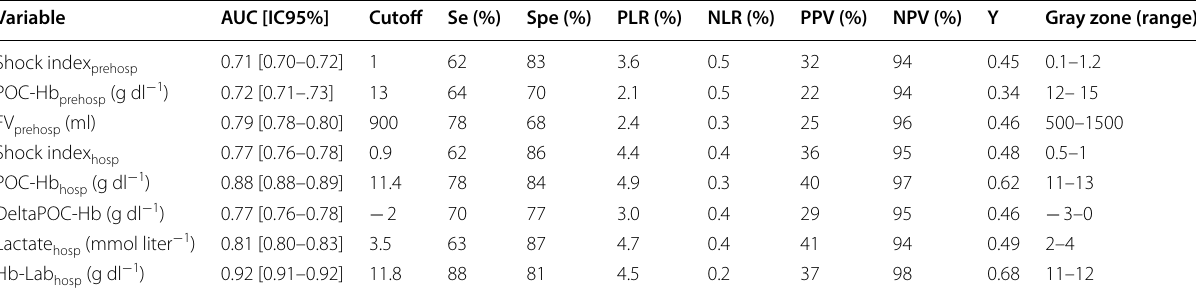
Table 3 Predictive performances of different variables for significant